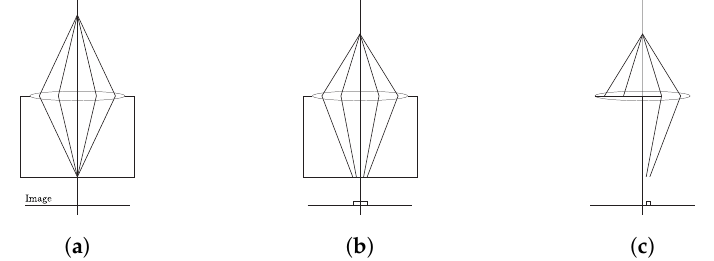
Figure 3. Principle of single lens stereo: ( a ) Point object in the focal plane of the main lens; ( b ) Point object closer than the focal plane; ( c ) Eccentric aperture creating a cropped image (adapted from